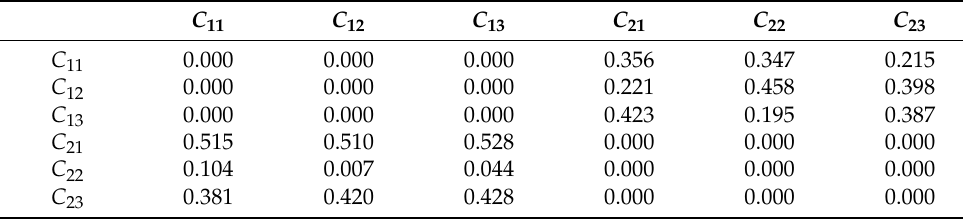
Table 1. Unweighted super-matrix.